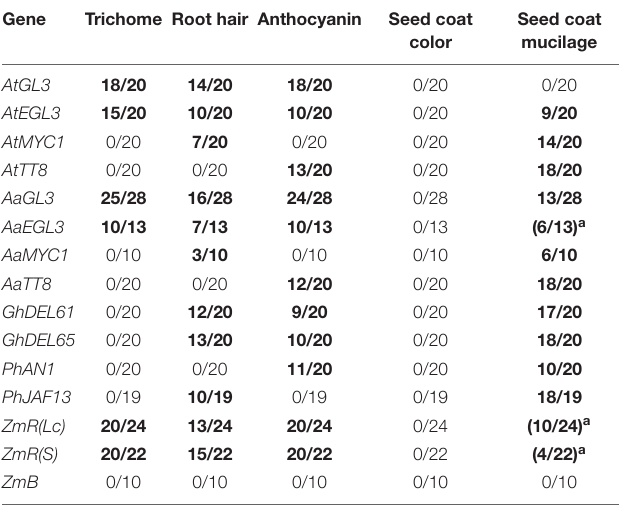
TABLE 2 | T1 plants or T2 lines transformed by pAMPAT-35S:bHLH showing phenotypic rescue (rescued lines/total number of lines) in gl3/egl3/tt8 . Gene Trichome Root hair Anthocyanin Seed coat